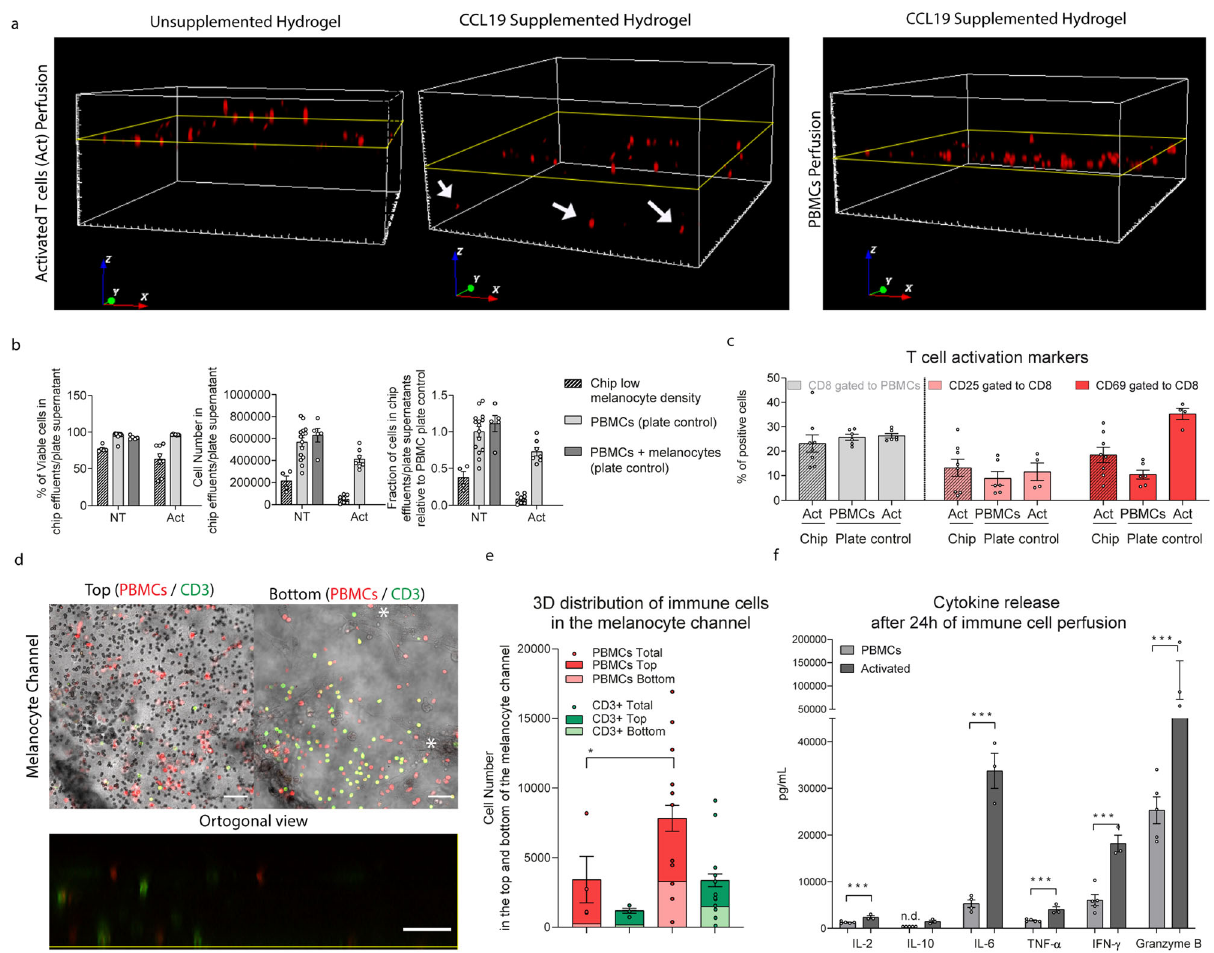
Fig. 4 Validation of PBMC perfusion, viability, recruitment and cytokine release upon activation with anti CD3/CD28 antigens (Act). a 3D representations of the evaluation of immune cell recruitment on chip containing only hydrogel (left) or supplemented with CCL19 (middle and right) and perfused with Deep Red cell tracker labeled PBMCs, treated with anti CD3/CD28 antigens (middle and left) or non-treated (right) showing that in the absence of a stimuli, there is no immune cell recruitment. The yellow line represents the position of the bottom membrane of the chip. b Evaluation of the cells collected after 24 h of perfusion on its viability (left), concentration (middle) and fraction of recovery relative to the plate control ( n = 4 – 15) measured by fl ow cytometry. The ef fl uents were collected from the chips with low melanocyte density (black) and from control well plates with (dark gray) or without co-culture with melanocytes (light gray). c Quanti fi cation of CD8 positive cells and of T cell activation markers CD25 and CD69 within the CD8 positive population by fl ow cytometry analysis of the ef fl uents in the chips with low melanocyte density (striped bars) and on the plate controls ( n = 4 – 8). d Evaluation of the immune cell recruitment towards the 3D melanocyte compartment in chips with low melanocyte density and activated (Act) distinguishing PBMCs (red) and T cells (green, labeled with an anti-CD3 antibody) within the melanocytes (*). The fi gure shows the top of the compartment where the chip bottom membrane is located and its pores are focused (right) and the bottom of the compartment (left), with an orthogonal representation of the whole chip height (bottom). Scale bar is 50 µ m. e Quanti fi cation of immune cell recruitment by image analysis of the whole chip with low melanocyte density, distinguishing PBMCs (cell tracker labeled prior perfusion) and T cells (CD3 post fi xation staining) in the top (dark red and green) and bottom (light red and green) halves of the melanocyte compartment in the chips with low melanocyte density. Statistical analysis represents the comparison of total immune cells between chips perfused with PBMCs and chips perfused with activated cells (* P < 0.1, n = 4 for NT and n = 12 for Act). f Quanti fi cation of the cytokines IL-2, IL-10, IL-6, IFN- γ , TNF- α and granzyme B on the ef fl uents of chips after 24h of perfusion. Statistical analysis represents the comparison between chips with low melanocyte density perfused with PBMCs and chips perfused with activated cells (*** P < 0.01, n = 3 – 5). Bars represent averages± SEM. Statistical analysis is detailed in Supplementary data 1, including detailed information of the number of biological replicates per group, exact p values and individual data a reduction on CD69 expression in CD8a positive cells, statisti- cally signi fi cant for both concentrations (Fig. 5c), a reduction of all measured cytokines in the chip (Fig. 5d) and of all except for IL-2 in the plate controls (Fig. 5e). The IL-2 increase in chips caused by T cell activation is slightly reverted in the high CsA